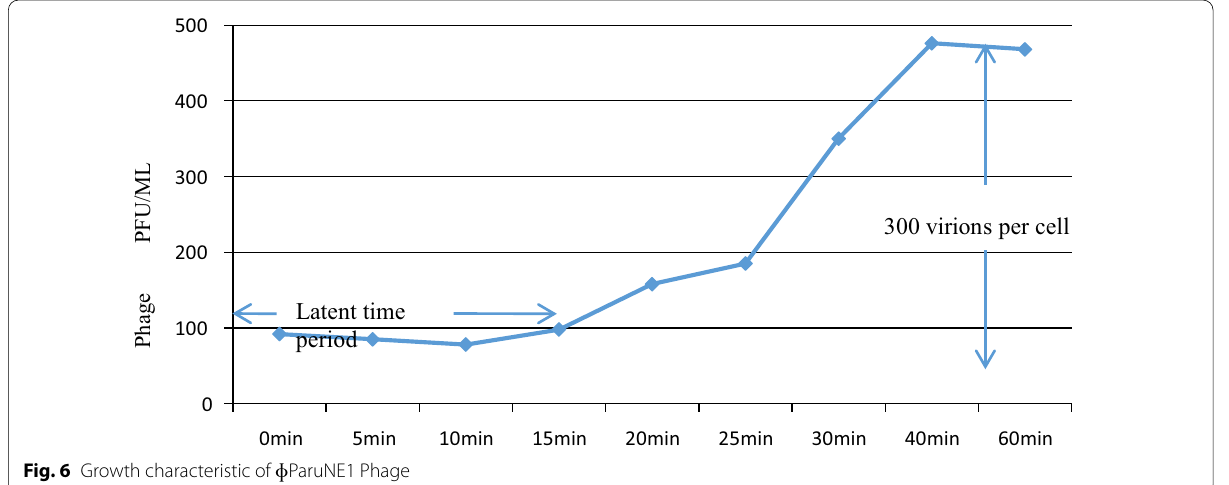
Fig. 6 Growth characteristic of ɸ ParuNE1 Phage